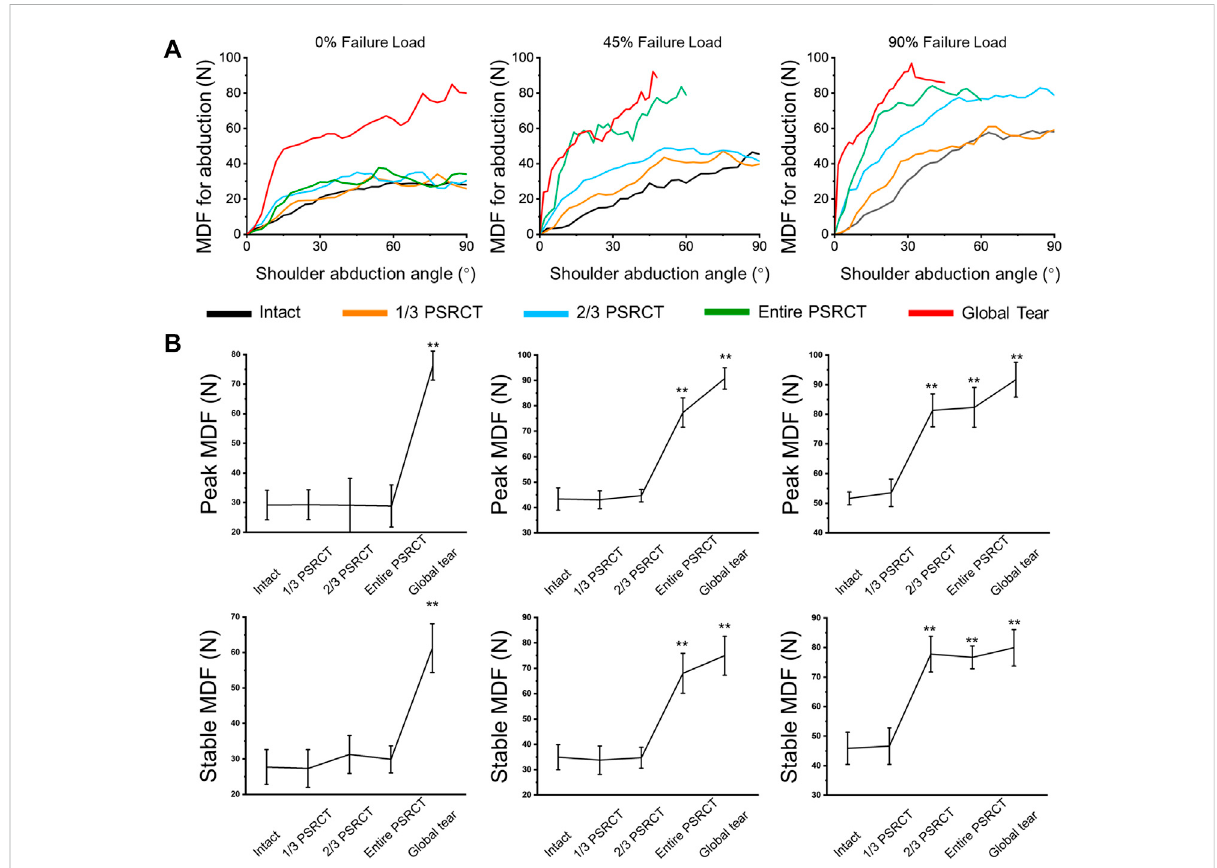
FIGURE 4 EffectofRCTonMDFduringabduction. (A) TheMDFcurvesoftheintact,1/3,2/3,entire,andglobaltearconditionsunder0,45,and90%failure loads. (B) The peak and stable MDFs during 60 ° glenohumeral abduction. MDF, middle deltoid force. **, a signi fi cant difference compared with the intact condition, p < 0.01.